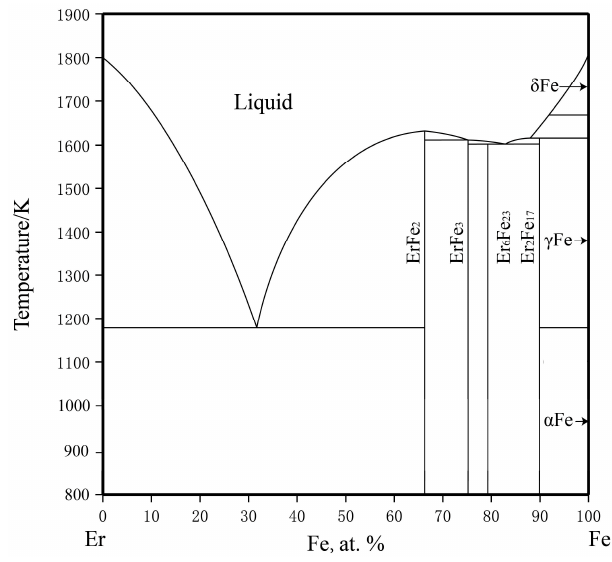
Figure 2. The calculated Er-Fe phase diagram based on the work of Zhou et al. [42].